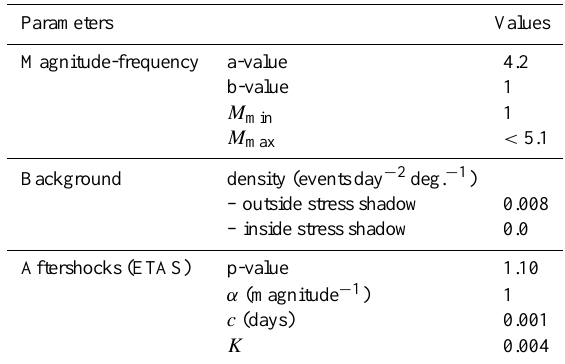
Table 1. List of Parameters used in the synthetic